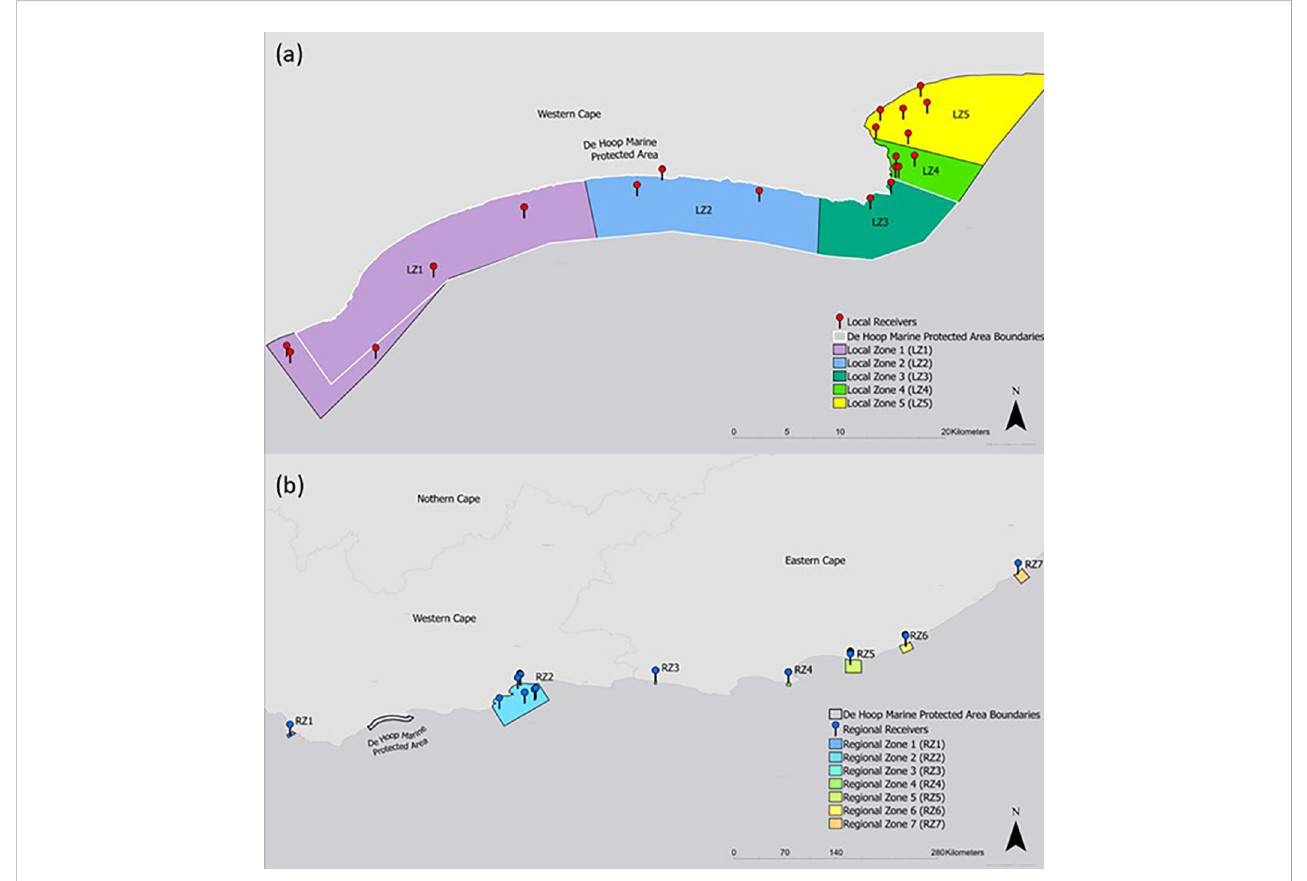
FIGURE 2 Network analysis nodes represented as zones on (A) local and (B) regional levels. Receiver stations included in each zone are displayed along with boundaries of the De Hoop